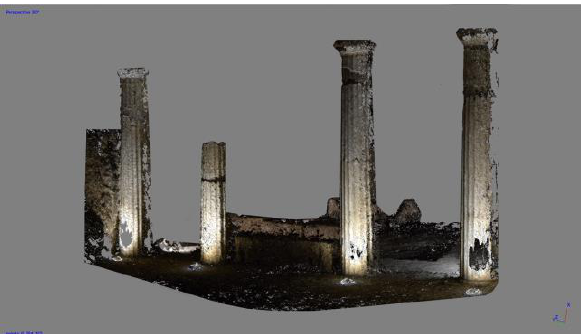
Figure 16. The Tomb of Persephores in Verghina. Cloud of points, detail from the east.